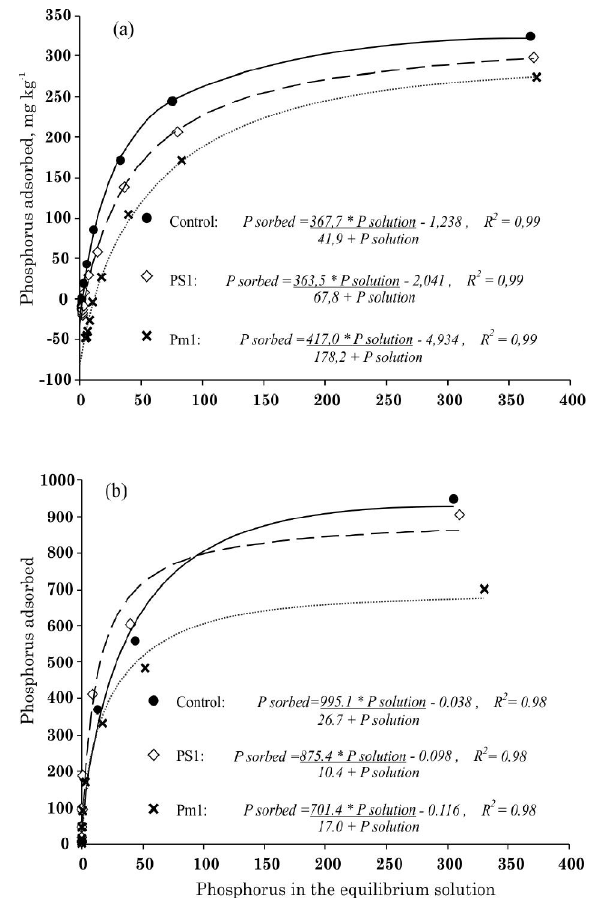
Figure 2. Ratio between the P adsorbed and the P in equilibrium solution of the soil in the 0-2.5 cm (a) and 20-30 cm (b) layers in a Typic Hapludult soil without pig litter fertilization, with the application of pig slurry (PS1) and of pig manure (PM1) in a no-till